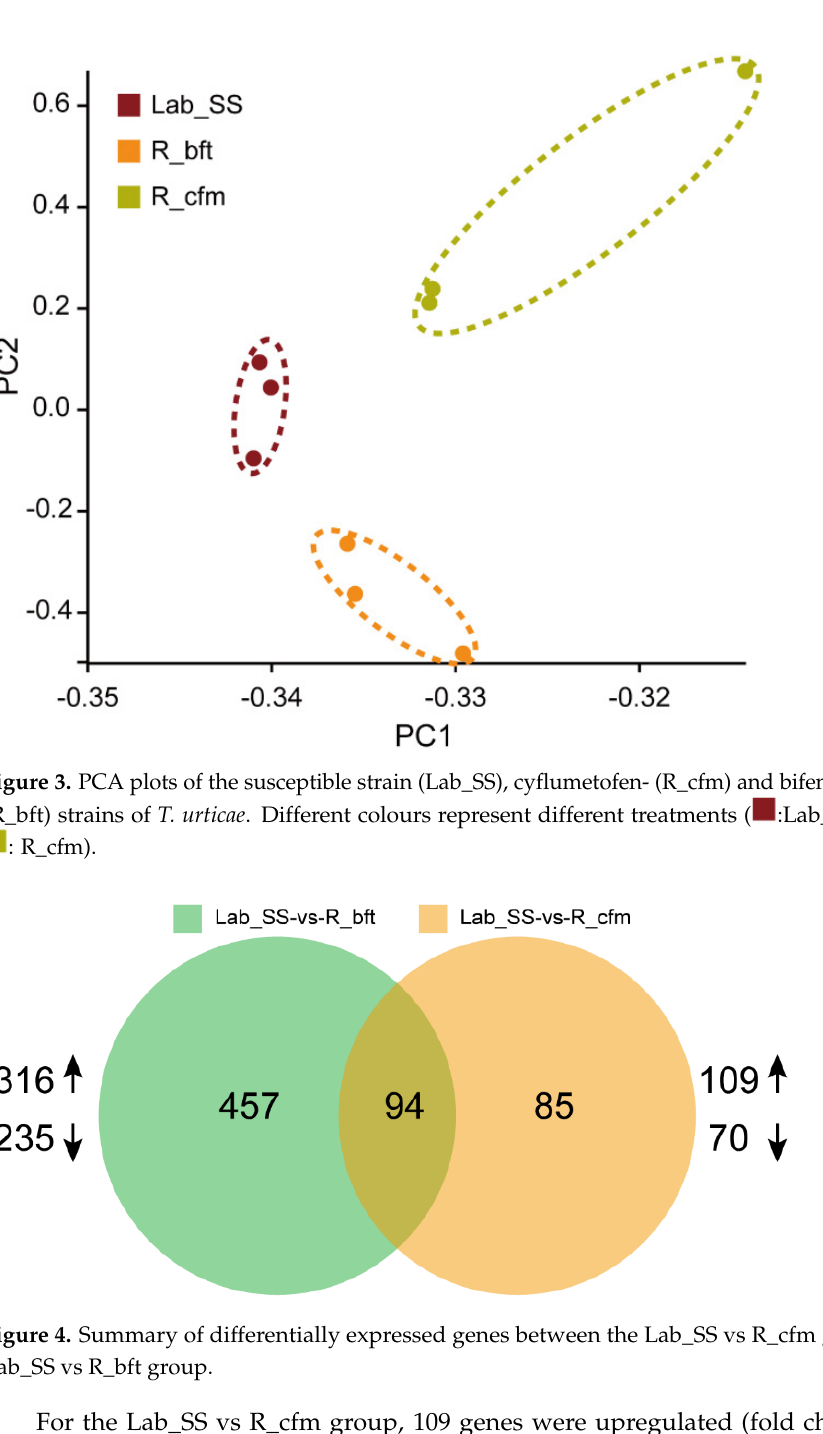
Figure 4. Summary of differentially expressed genes between the Lab_SS vs R_cfm group and the Lab_SS vs R_bft group. For the Lab_SS vs R_cfm group, 109 genes were upregulated (fold change ≥ 2.00 and adjusted p value < 0.05) and 70 genes were downregulated, which was presented in the